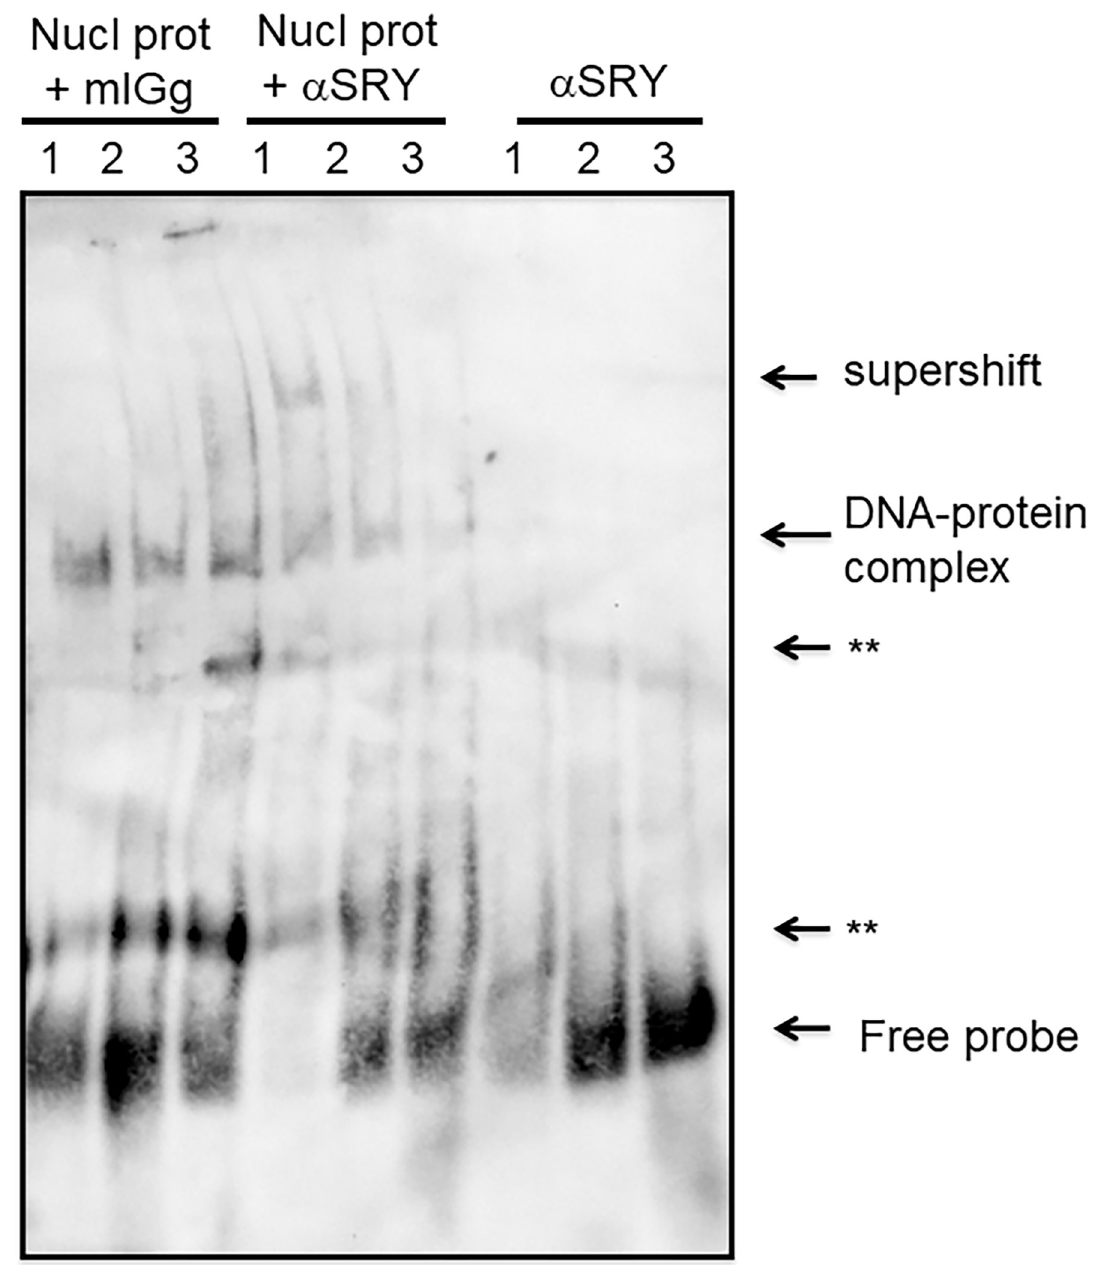
Fig 5. Supershift of SRY1 and 2 sites with the SRY antibody. Experiments were performed with biotin labeled probes in the same conditions as EMSA assays previously performed, blotted to nylon membranes and revealed with Streptavidin-HRP by chemiluminescence detection. Lines 1, 2 and 3 contain biotin-labeled WT SRY sites (1–3, respectively), with nuclear proteins from SRY transfected HEK293 cells and IgG mouse, and the same probes with nuclear proteins plus 0.4 μ g of monoclonal SRY antibody ( α SRY). Arrows indicate the DNA-protein complexes and the supershift in the SRY1 and SRY2 sites. The asterisks indicate non-specific bands, and the negative control of unspecific binding of the SRY antibody with biotin-labeled probes (without nuclear proteins) is shown in the three lanes at the